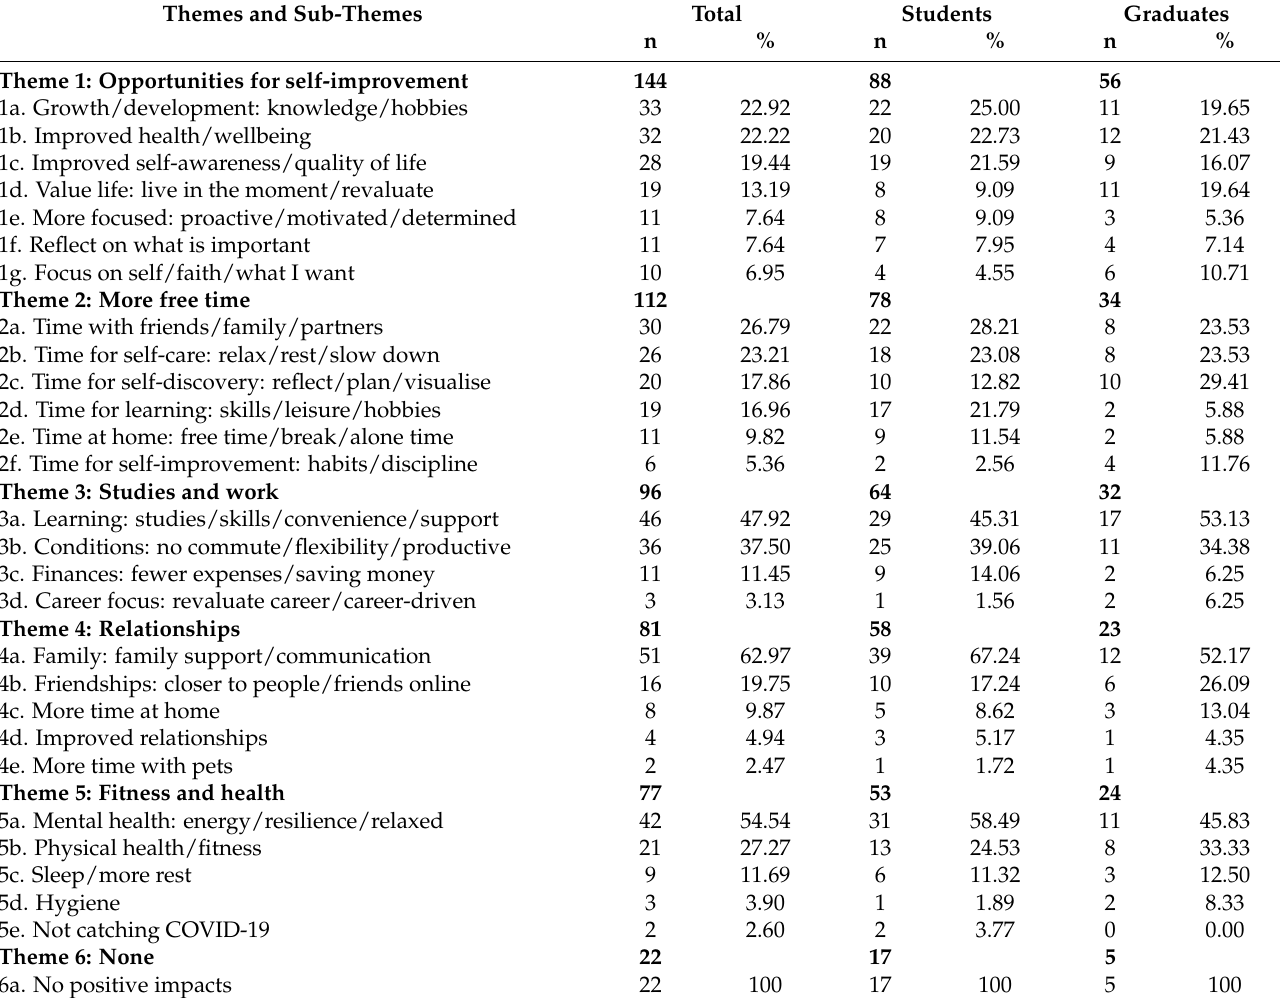
Table 6. Perceived positive outcomes of COVID-19 on subjective wellbeing (n =